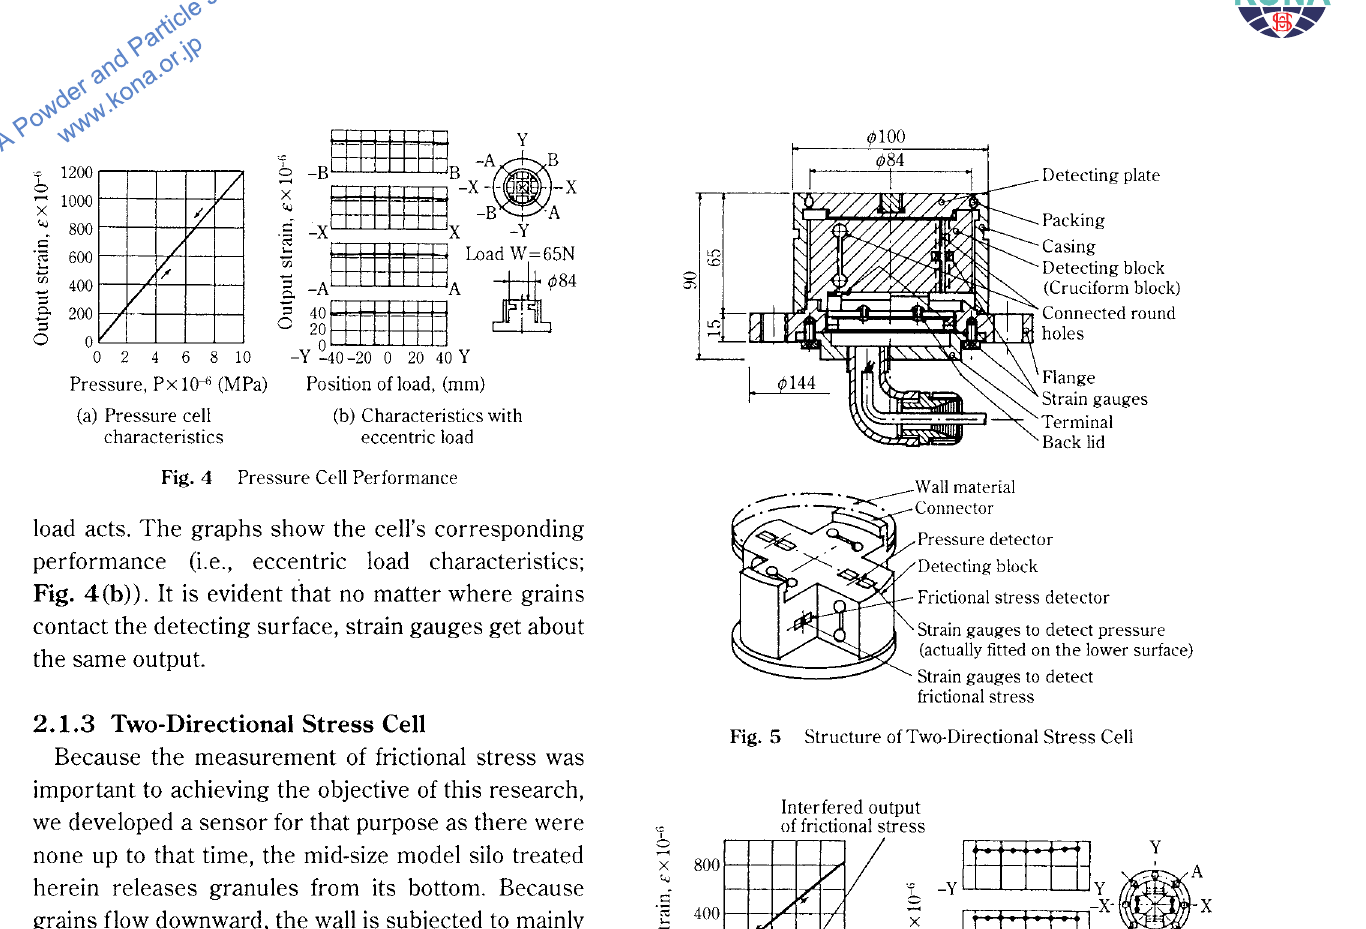
Interfered output ~ of frictional stress